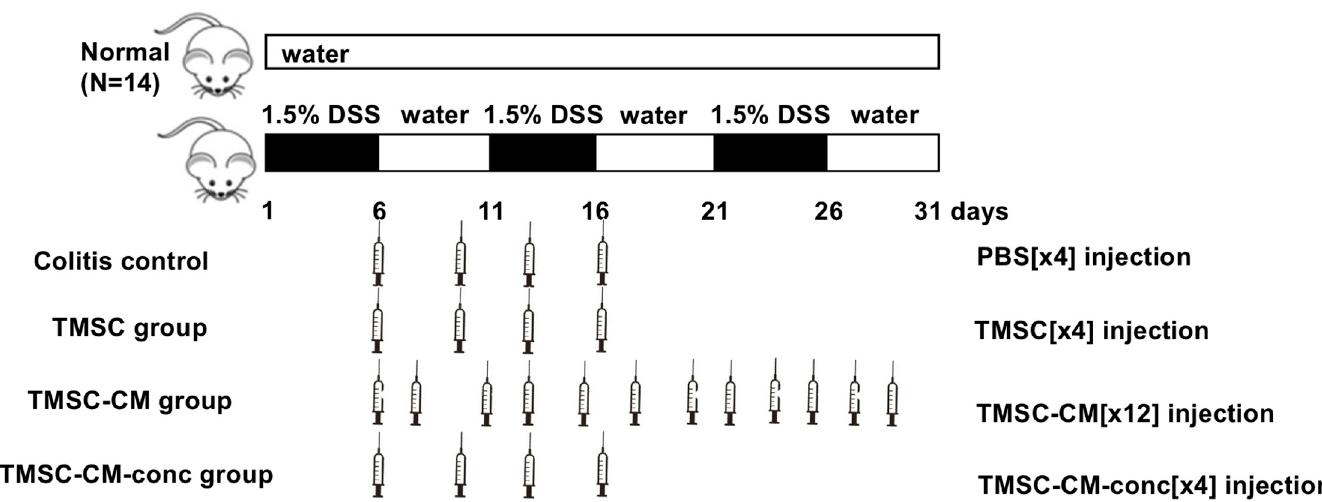
Fig 1. Experimental design. Mice were randomly assigned into 5 groups: the normal control, colitis control, TMSC injection, TMSC-CM injection, TMSC-CM-conc injection groups. Mice in the colitis control group received 4 IP injections of PBS, those in the TMSC group received 4 IP injections of TMSC, those in the TMSC-CM group received 12 IP injections of TMSC-CM, and those in the TMSC-CM-conc group received 4 IP injections of triple-concentrated TMSC-CM. DSS, dextran sulfate sodium; PBS, phosphate buffered saline.